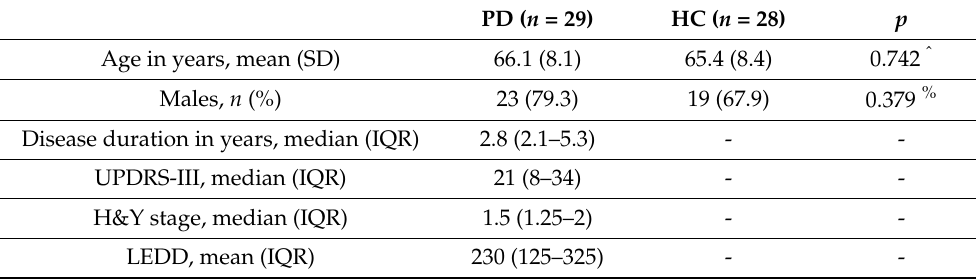
Table 1. Demographic and clinical characteristics of study